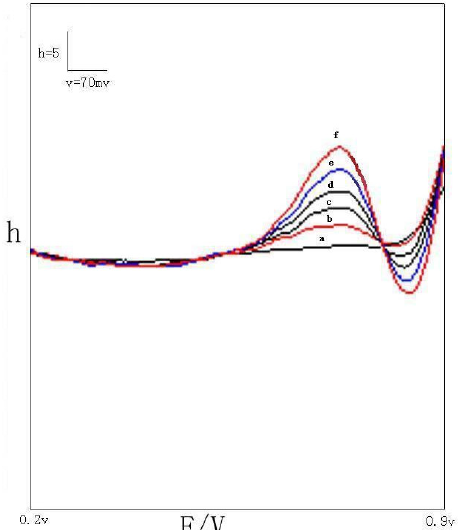
Fig. 4. Peak height- voltage curve of the modified platinum microelectrode to the successive additions of NO in seawater. Curve a, without NO; Curve b, [NO]=1.05 • mol/l; Curve c:[NO]=2.1 • mol/l; Curve d: [NO]=3.15 • mol/l; Curve e: [NO]=4.2 • mol/l; Curve f: [NO]=5.25 • mol/l.